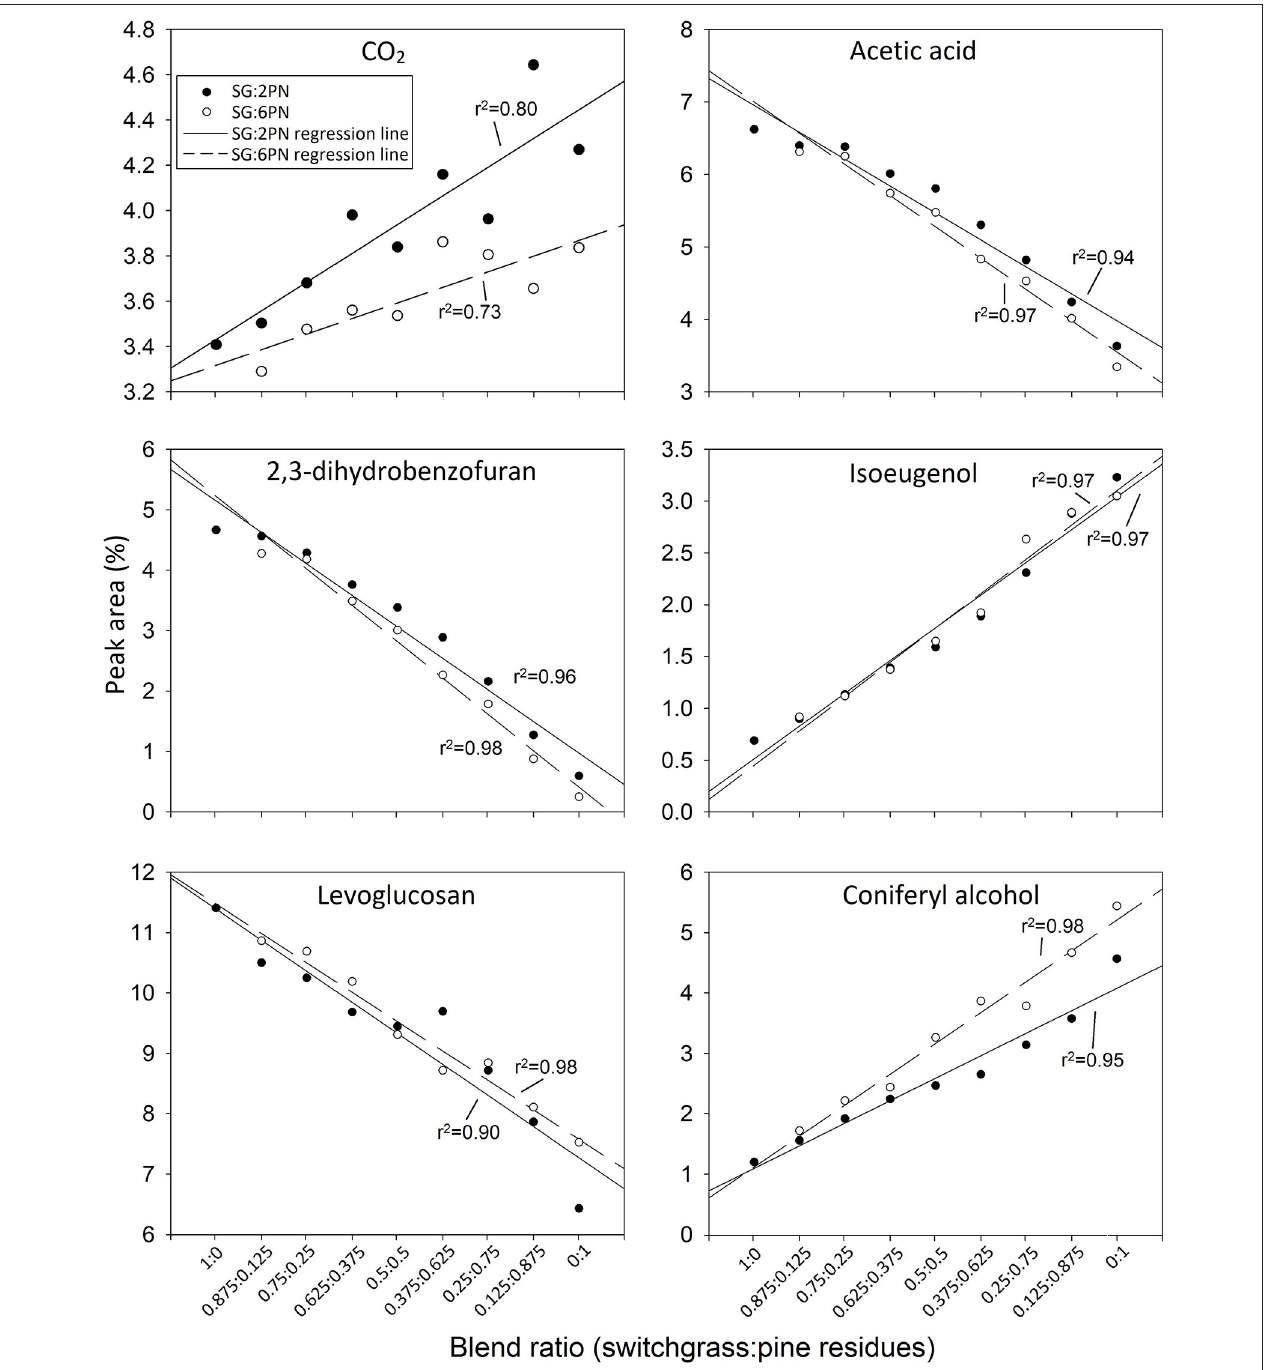
FIGURE 4 | Trends between % peak area for several vapor-phase pyrolysis products measured by Py-GC/MS and biomass blend fraction for blended samples composed of switchgrass and pine residues.